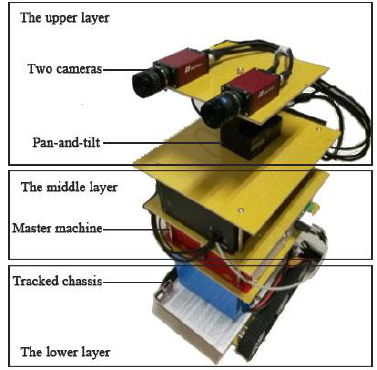
Fig. 1 The unmanned vehicle with three independent hierarchical